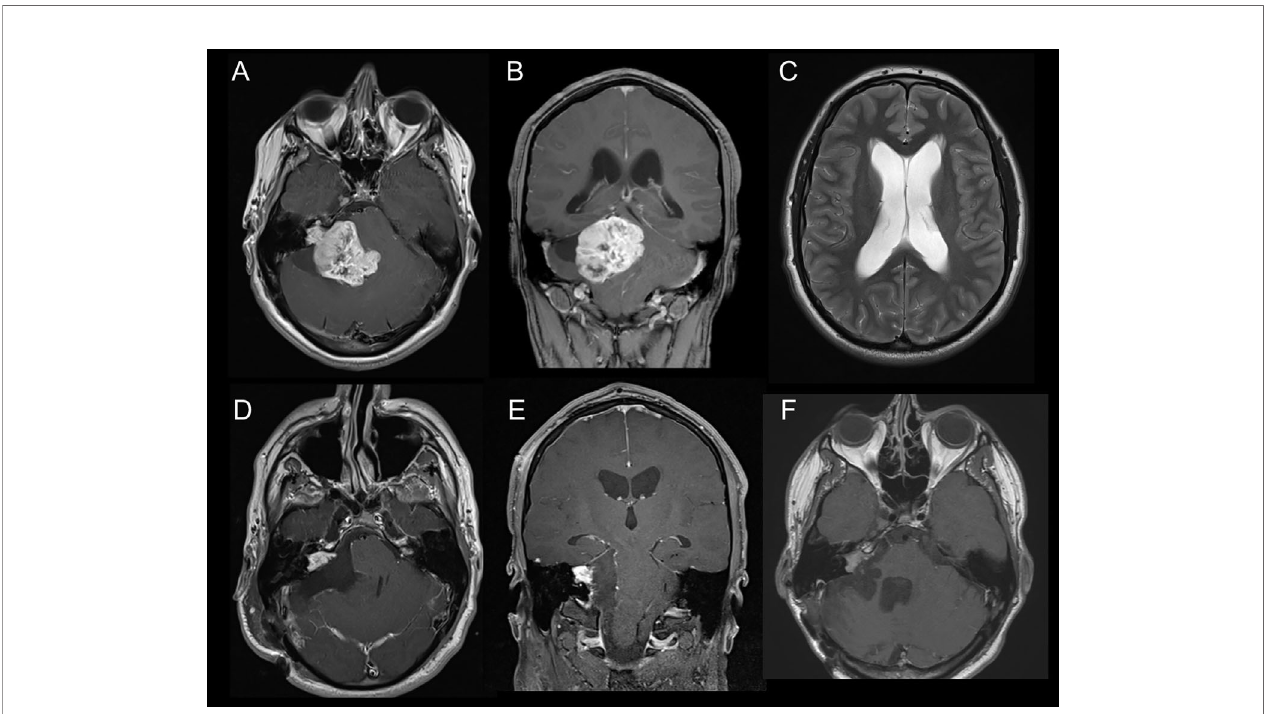
FIGURE 1 | (A) Axial slice of MRI-T1Gd showing vestibular schwannoma KOOS IV on the right side. (B) Coronar slice of MRI-T1Gd. (C) Axial slice of MRI-T2 showing hydrocephalus with Evan´s ratio >0.3. (D) Axial slice of postoperative MRI-T1Gd showing residual tumor in the meatus acousticus internus. (E) Coronar slice of postoperative MRI-T1Gd. (F) Follow-up Image of MRI-T1Gd showing stable residual tumor after adjuvant